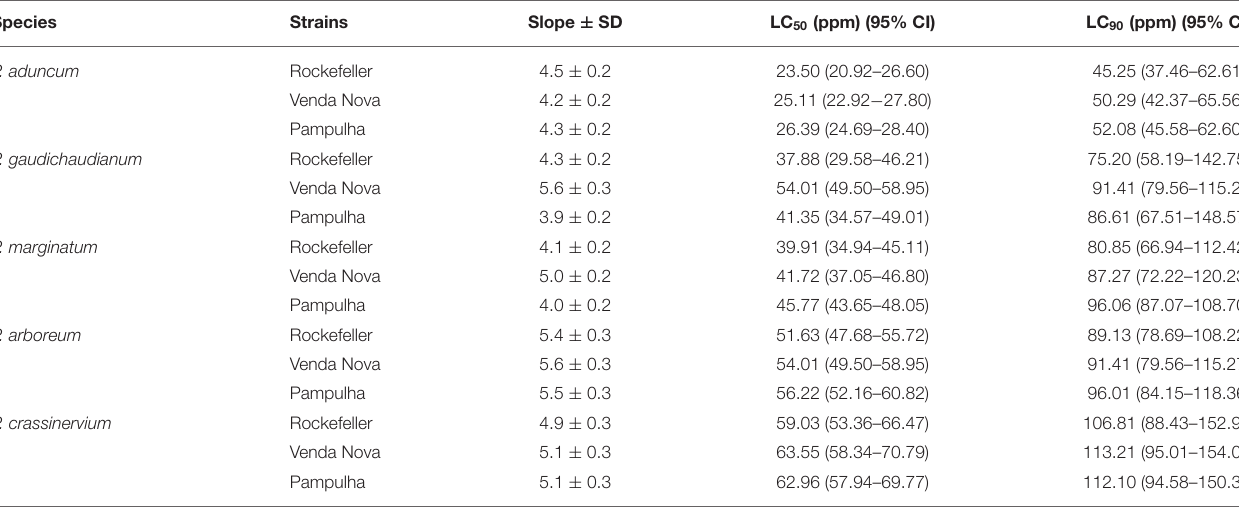
TABLE 4 | Lethal concentrations of essential oil of Piper species against Aedes aegypti larvae resistant and susceptible strains to pyrethroids, during 24h of exposure. Species Strains Slope ± SD LC 50 (ppm) (95% CI) LC 90 (ppm) (95% CI)